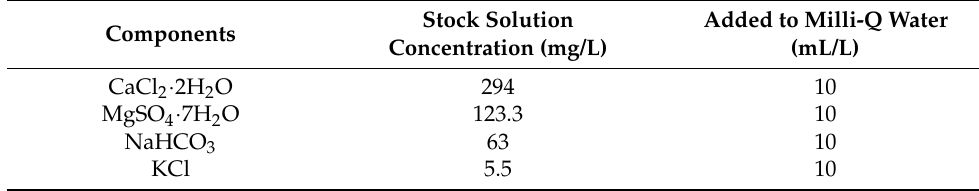
Table 1. The preparation formula for artificial freshwater (AFW). Stock Solution Components Concentration